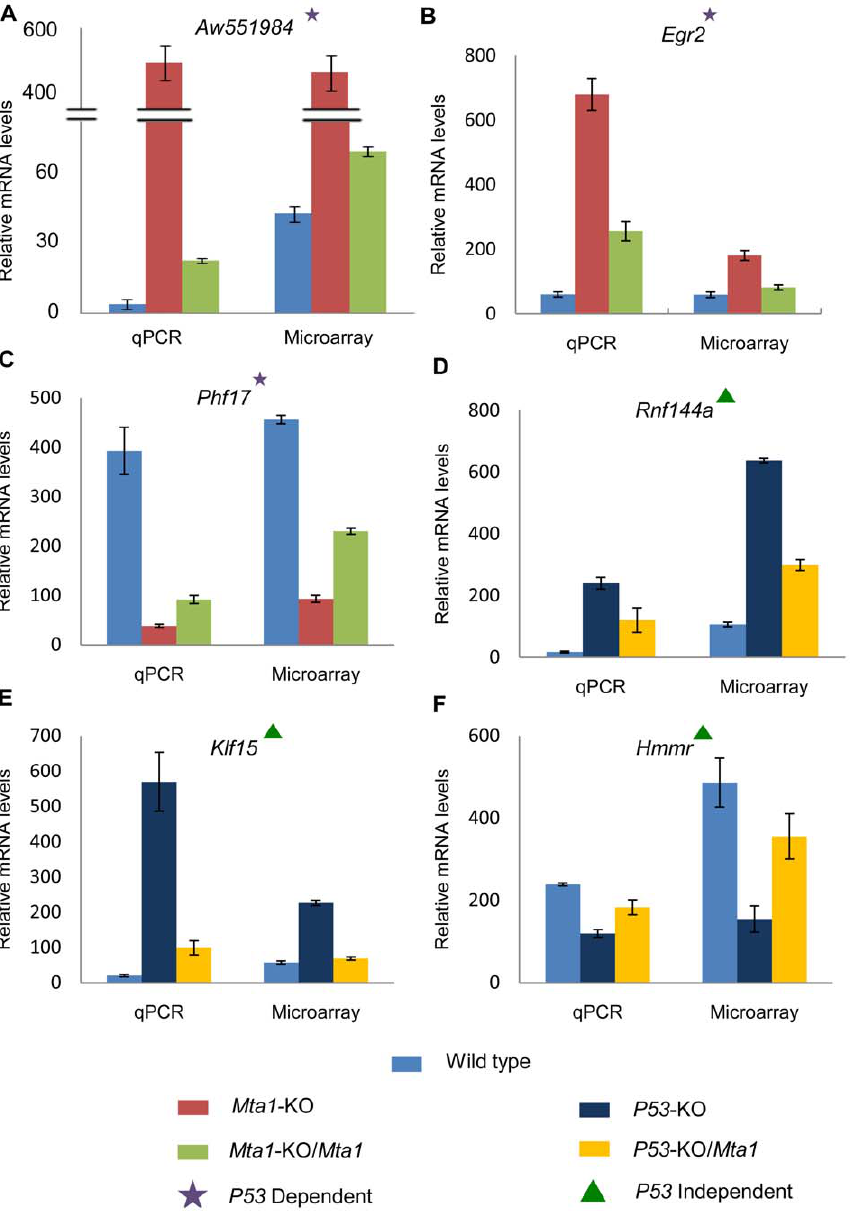
Figure 7. RT-qPCR validation of the microarray data showing the differential regulation of the selected genes in the MEFs. The RNA extracted from the fibroblasts of the wild type (light blue bars) mice was used as the control and the treatments were Mta1 -KO (red bars) & Mta1 -KO/ Mta1(green bars) . In the presence of P53 relative mRNA levels of the genes Aw551984 , Egr2 , Phf17 were compared in all the three samples. The relative mRNA levels from microarray for the same sample sets were plotted and compared with the RT-qPCR. As expected, opposite trends of expression were observed between the knock out and re-expression models. To validate the genes regulated by Mta1 in the absence of P53 relative mRNA levels were compared among the three samples wild type (light blue bars), P53 -KO (dark blue bars) & P53 -KO/ Mta1 (yellow bars) for the genes Hmmr , Klf15 , Rnf144a .The relative mRNA levels from the microarray were plotted and compared with RT-qPCR. Opposite trends of expression were observed between the P53 -KO and P53 -KO/ Mta1 treatments when compared with the wild type